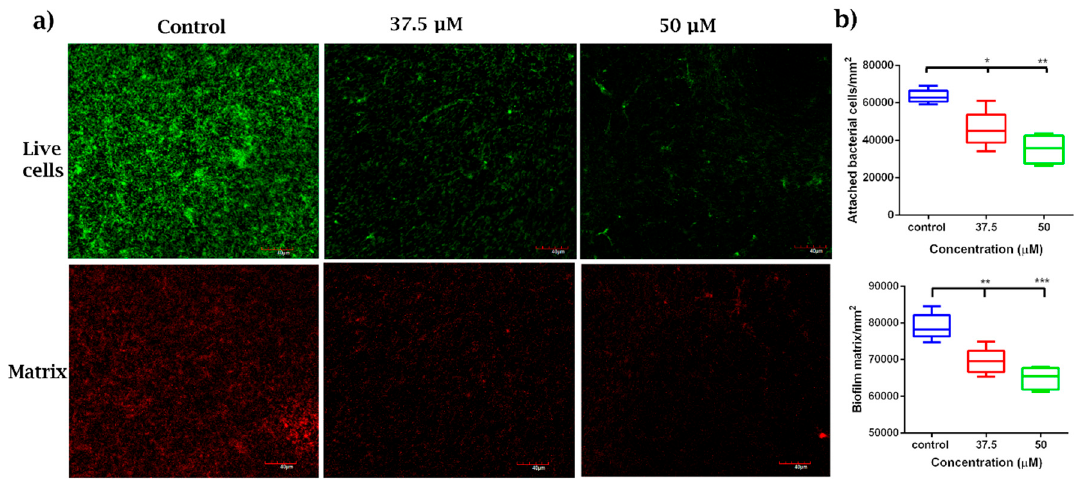
Figure 6. DMTU treatment of pre-formed biofilms. ( a ) Panel shows CLSM images of matrix (stained red by the SyPRO matrix stain) and live cells (stained green by Syto9) when treated with DMTU; ( b ) quantitative analyses of attached bacterial cells / mm2 and biofilm matrix / mm2 showed significant reduction in biofilm matrix by DMTU. * denotes p ≤ 0.05, ** denotes p ≤ 0.01 and *** denotes p ≤ 0.001.